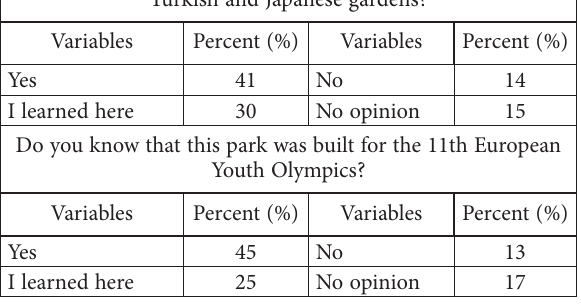
Table 7. Park usage choices